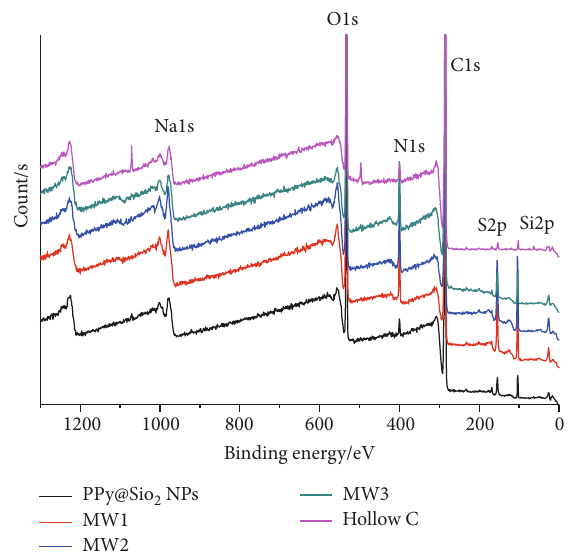
@PPy NPs, samples after microwave, 2 @PPy NPs, 2